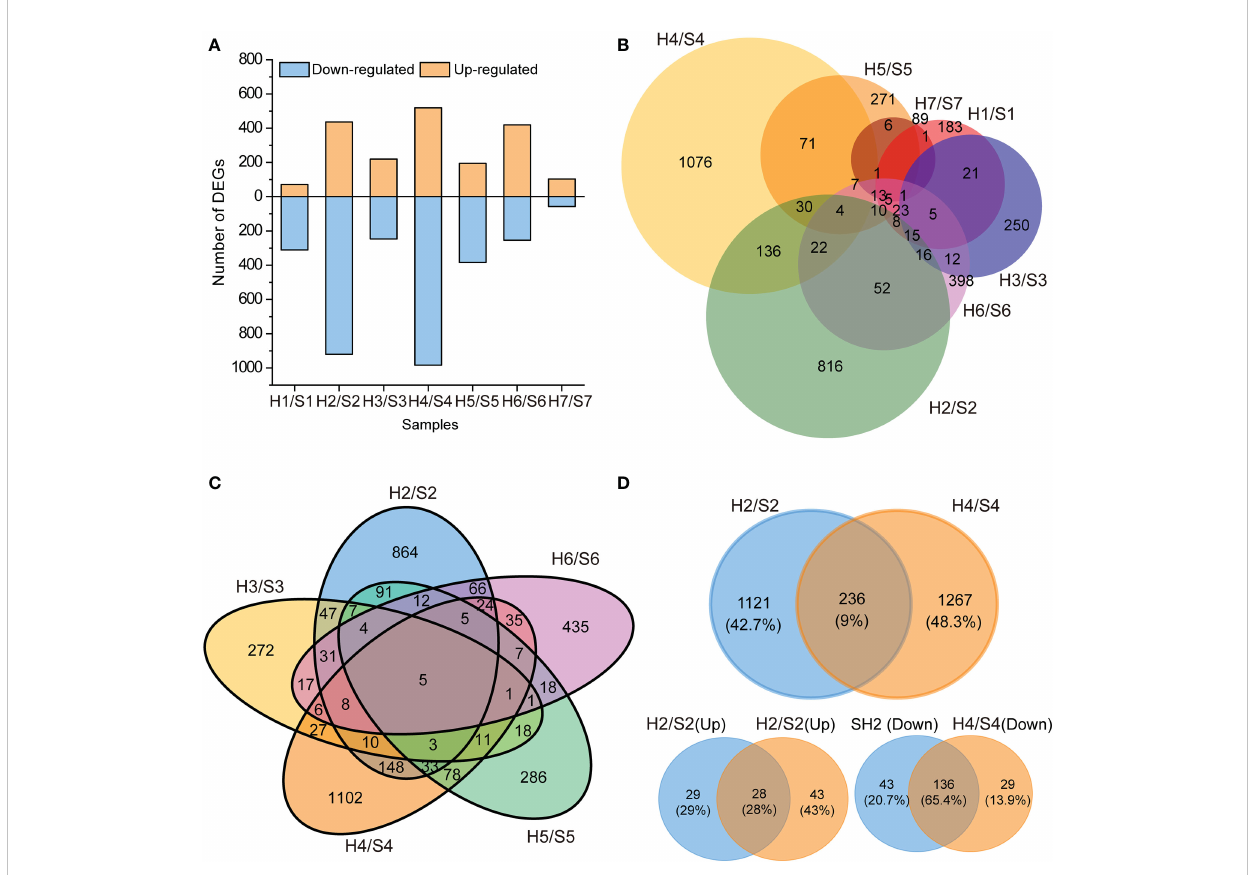
FIGURE 3 Statistical chart of differentially expressed genes (DEGs) transcriptome in response to drought stress. (A) , Number of DEGs (up- and down- regulated). (B) , Venn diagram of DEGs in the seven sweet potato cultivars under the drought stress. (C) , Venn diagram of DEGs in the fi ve sweet potato cultivars under the drought stress. (D) , Venn diagram of DEGs in S2 and S4 sweet potatoes under the drought stress. H1/S1, drought-treated Shangshu-9/control Shangshu-9; H2/S2, drought-treated Chaoshu-1/control Chaoshu-1; H3/S3, drought-treated Xushu-22/control Xushu-22; H4/ S4, drought-treated Z15-1/control Z15-1; H5/S5, drought-treated Xushu-18/control Xushu-18; H6/S6, drought-treated Jishu-26/control Jishu-26; H7/S7, drought-treated Xuzi-8/control